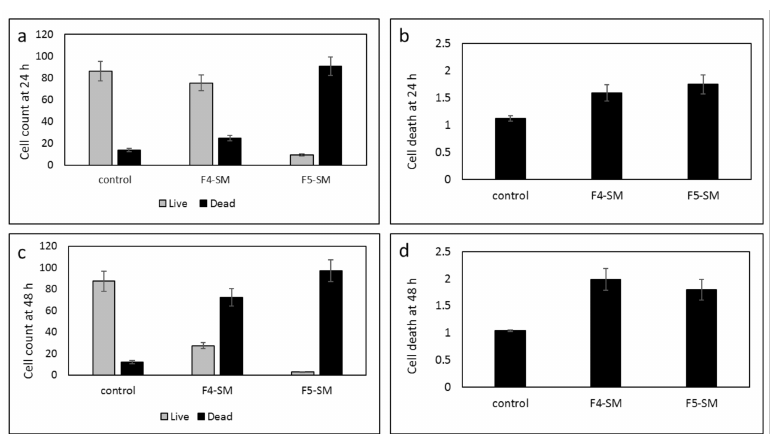
Figure 6. Cell viability of GSCs following treatment with F4-SM or F5-SM (10 µ g/mL) for 24 h ( a , b ), F4-SM or F5-SM for 48 h ( c , d ). Live/dead cell count was determined by trypan blue exclusion assay ( a , c ); LDH assay was used to determine cell death relative to vehicle control ( b , d ). Error bars indicate ± SE ( n = 3).